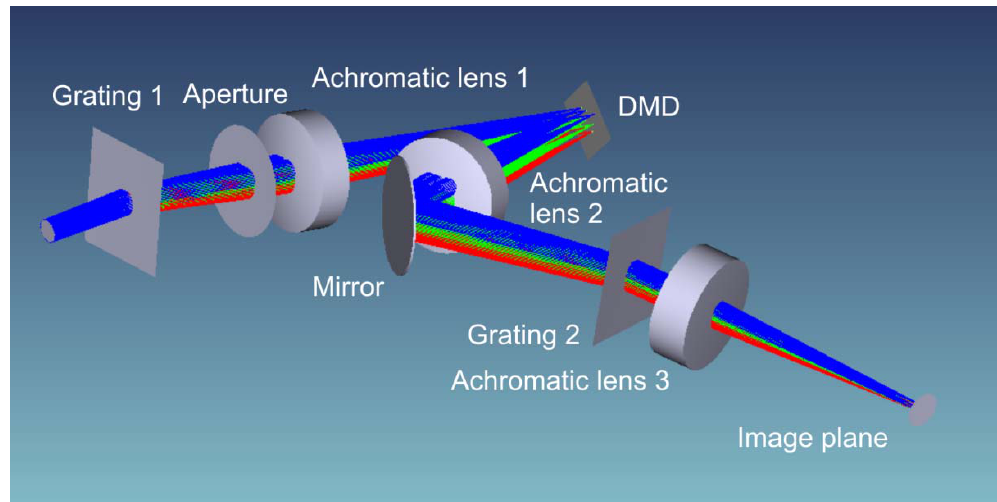
Figure 4. Optical layout of the sensor protection concept. A digital micromirror device (DMD) is located in the intermediate focal plane of a Keplerian telescope (Achromatic lens 1 and 2). Wavelength multiplexing is implemented by the use of two diffraction gratings (Grating 1 and 2). Grating 1 is aligned so that the spectral separation takes place in a plane perpendicular to the plane of reflection at the